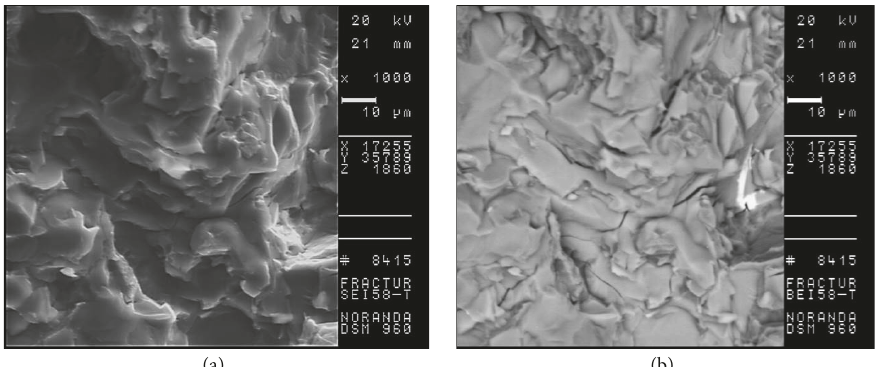
Figure 11: (a) Secondary electron image of the E alloy, 14wt% Al; (b) backscattered electron image of